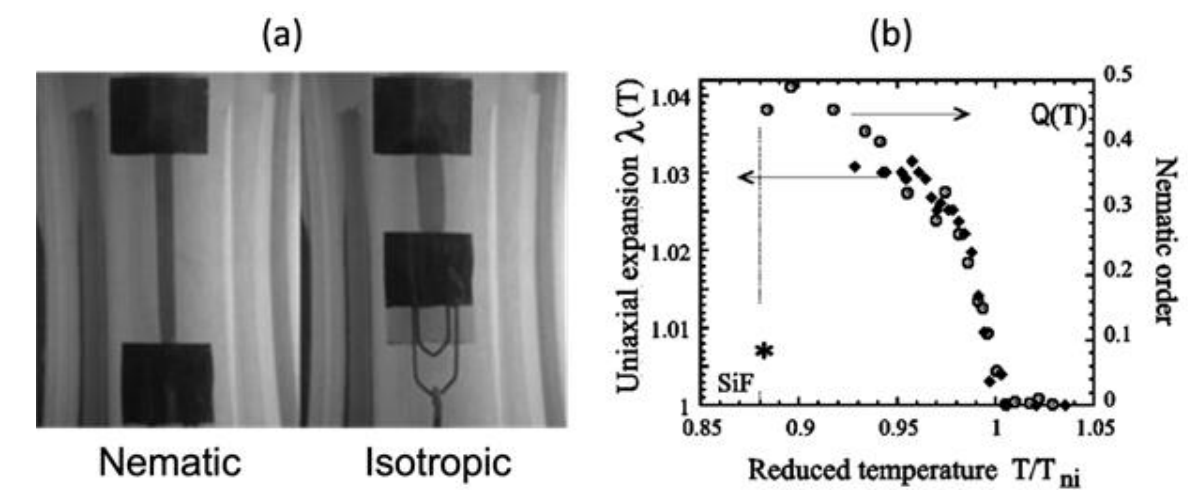
Figure 4. Spontaneous shrinkage of one-dimensional LCN strip: ( a ) strain induced by heating (Adapted with permission from Ref. [35]. 2010, Antoni Sanchez et al.); ( b ) order–strain relationship of LCN with flexible siloxane chain (SiF*) reported in [36]. The star and circle markers denote the uniaxial length change, and change of LC orientational symmetry, respectively (Adapted with permission from Ref. [36]. 2001, S. M. Clarke et al.).